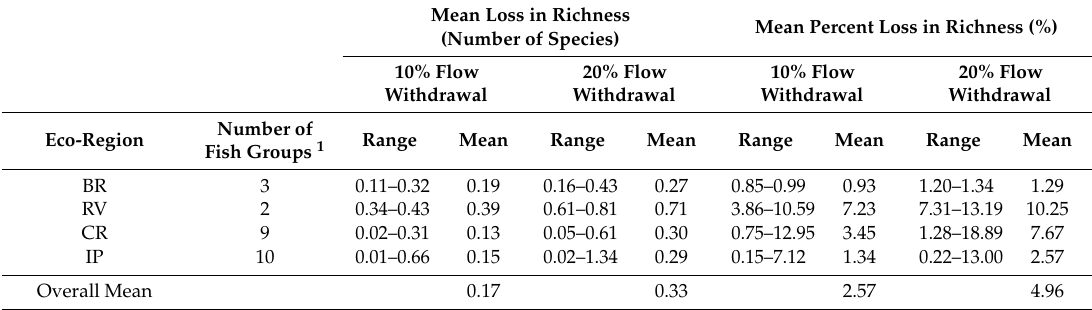
Table 4. Mean loss and mean percent-loss in predicted fish species across stream sites at 10 and 20% (POF) withdrawal scenarios for MFL0. Means calculated only among streams and fish groups that exhibited declines in